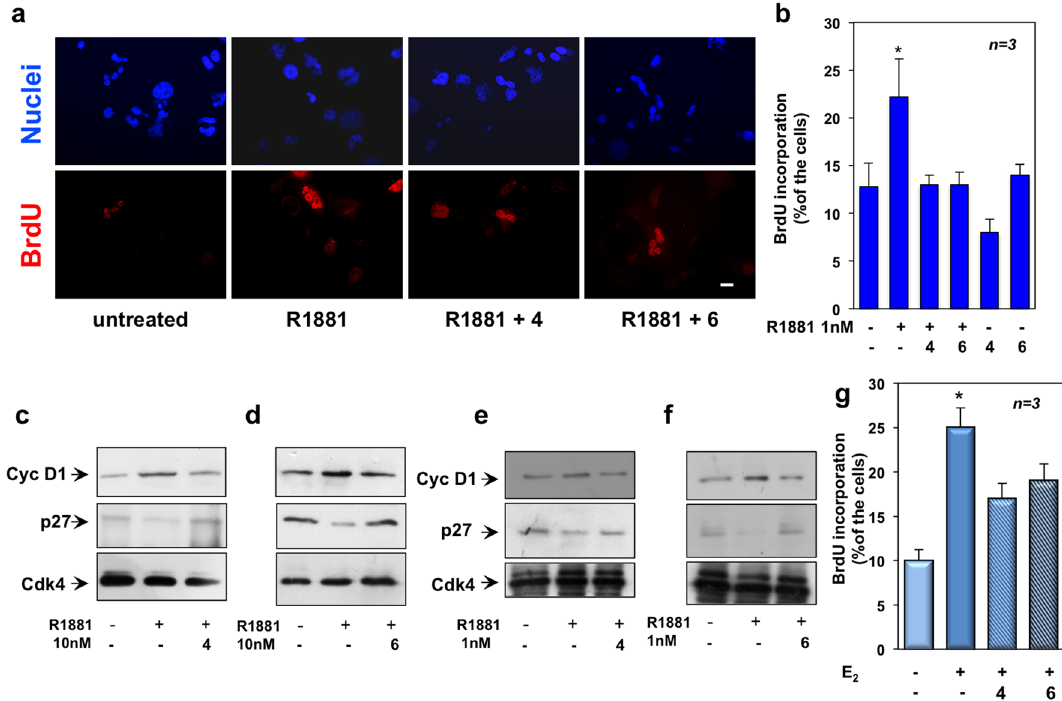
Figure 2. TRPM8 antagonists, 4 and 6, specifically affect the DNA synthesis and cell cycle progression elicited by androgens in LNCaP cells. LNCaP cells were employed. When indicated in Figure, the compounds 4 and 6 were used at 1 μM. Panel ( a ) shows representative images captured from one experiment presented in Fig. 1 (panels d , e ). Fluorescence (red) in the lower section is from reactivity with the anti-BrdU antibody. Hoechst 33,258 staining (blue) is shown in the upper section. Bar, 10 μM. In ( b ), quiescent cells on coverslips were left untreated or treated for 18 h with 1 nM R1881 in the absence or presence of the indicated compounds. Cells were pulsed in vivo with 100 μM BrdU and its incorporation into DNA was analyzed and expressed as in Fig. 1. In ( c – f ), quiescent cells were left untreated or treated with 10 nM R1881 ( c – d ) or 1 nM R1881 ( e – f ) for 15 h, in the absence or presence of the indicated compounds. Lysate proteins were prepared and analyzed by WB technique, using the antibodies against the indicated proteins. WB are representative of three different experiments and the corresponding densitometric analysis is reported in Supplementary Information. In ( g ), quiescent cells on coverslips were left untreated or treated for 18 h with 10 nM estradiol (E 2 ), in the absence or presence of the indicated compounds. Cells were pulsed in vivo with 100 μM BrdU and its incorporation into DNA was analyzed and expressed as in Fig. 1. In ( b , g ), means and standard errors (SEMs) are shown. n, represents the number of experiments. * p < 0.05 for the indicated experimental points vs. the corresponding untreated